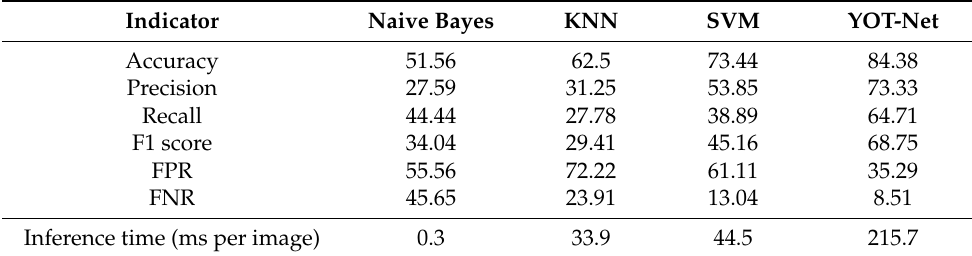
Table 1. Comparisons with the traditional classification methods.